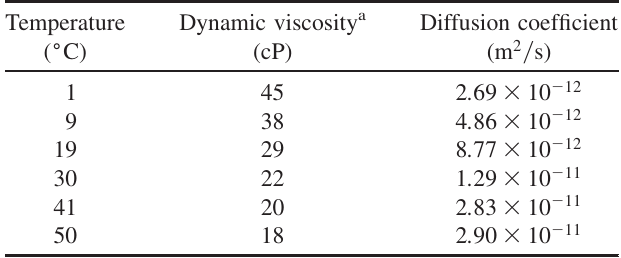
a The dynamic viscosity was calibrated against reference stan- dard with and without guardleg in place.